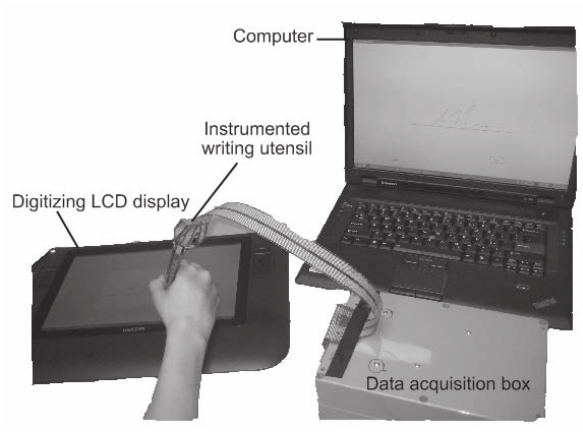
Figure 1. Data Collection instrumentation setup. Participants wrote with the instrumented writing utensil on a digitizing LCD display. The data acquisition box and the computer transmitted and saved the data